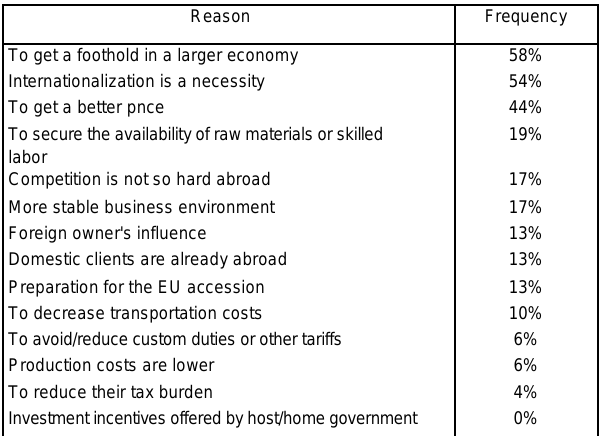
Table 9. The Reasons for Baltic Companies to Operate Abroad (N=48). (As a company may have several reasons for operating abroad, the sum of percentages exceeds 100%.)